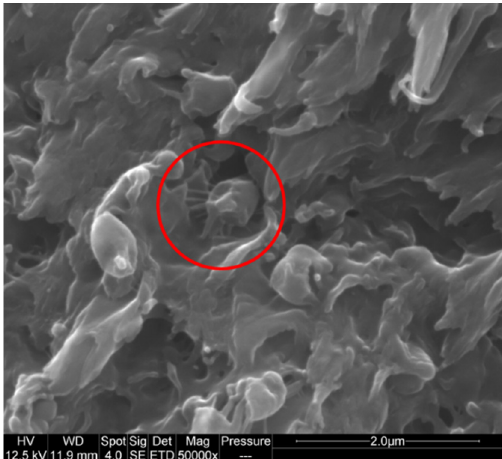
Figure 8. SEM picture of cross-sections of ABS-PP-PP-g-MA samples after tensile test—fibrils link- ing a potential PP nodule to the matrix. a potential PP nodule to the matrix.